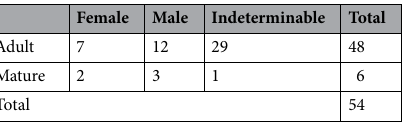
Table 4. Distribution of adult individuals by sex and